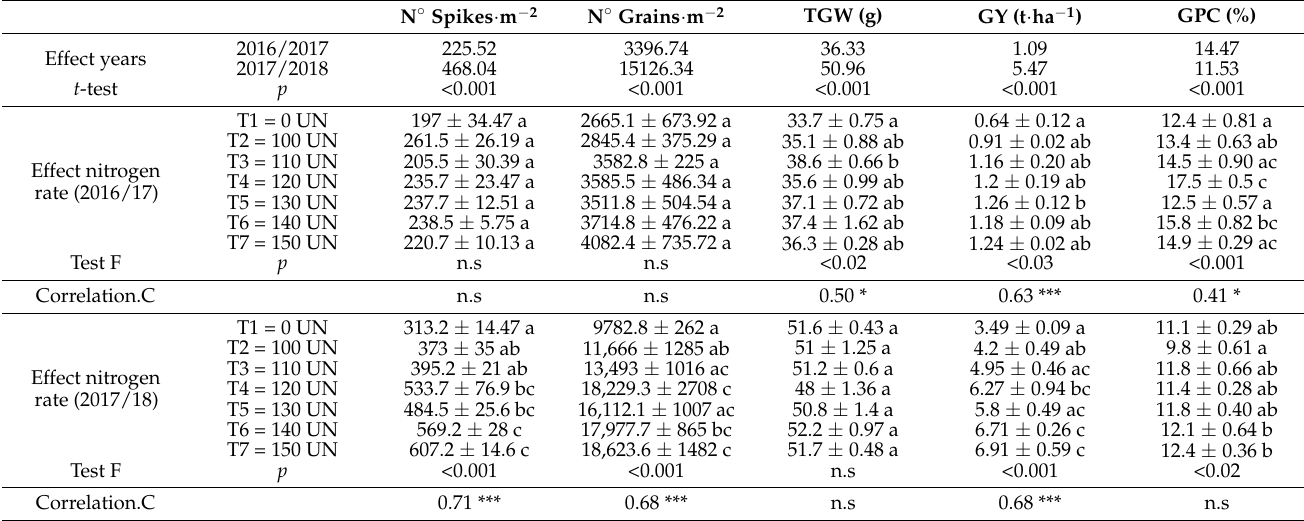
Table 3. Results of the ANOVA for the effect of N rate on GY and its components, GPC, and the t -test for the effect of